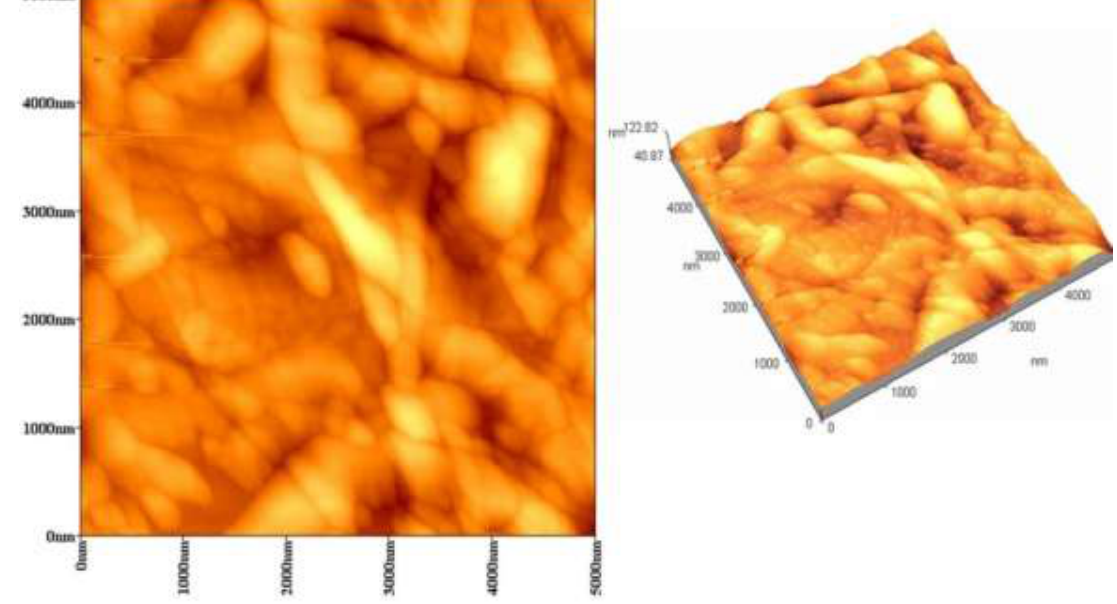
Figure 5: AFM images at an optimal concentration of the WO 3 thin film with substrate temperature 350 ͦ